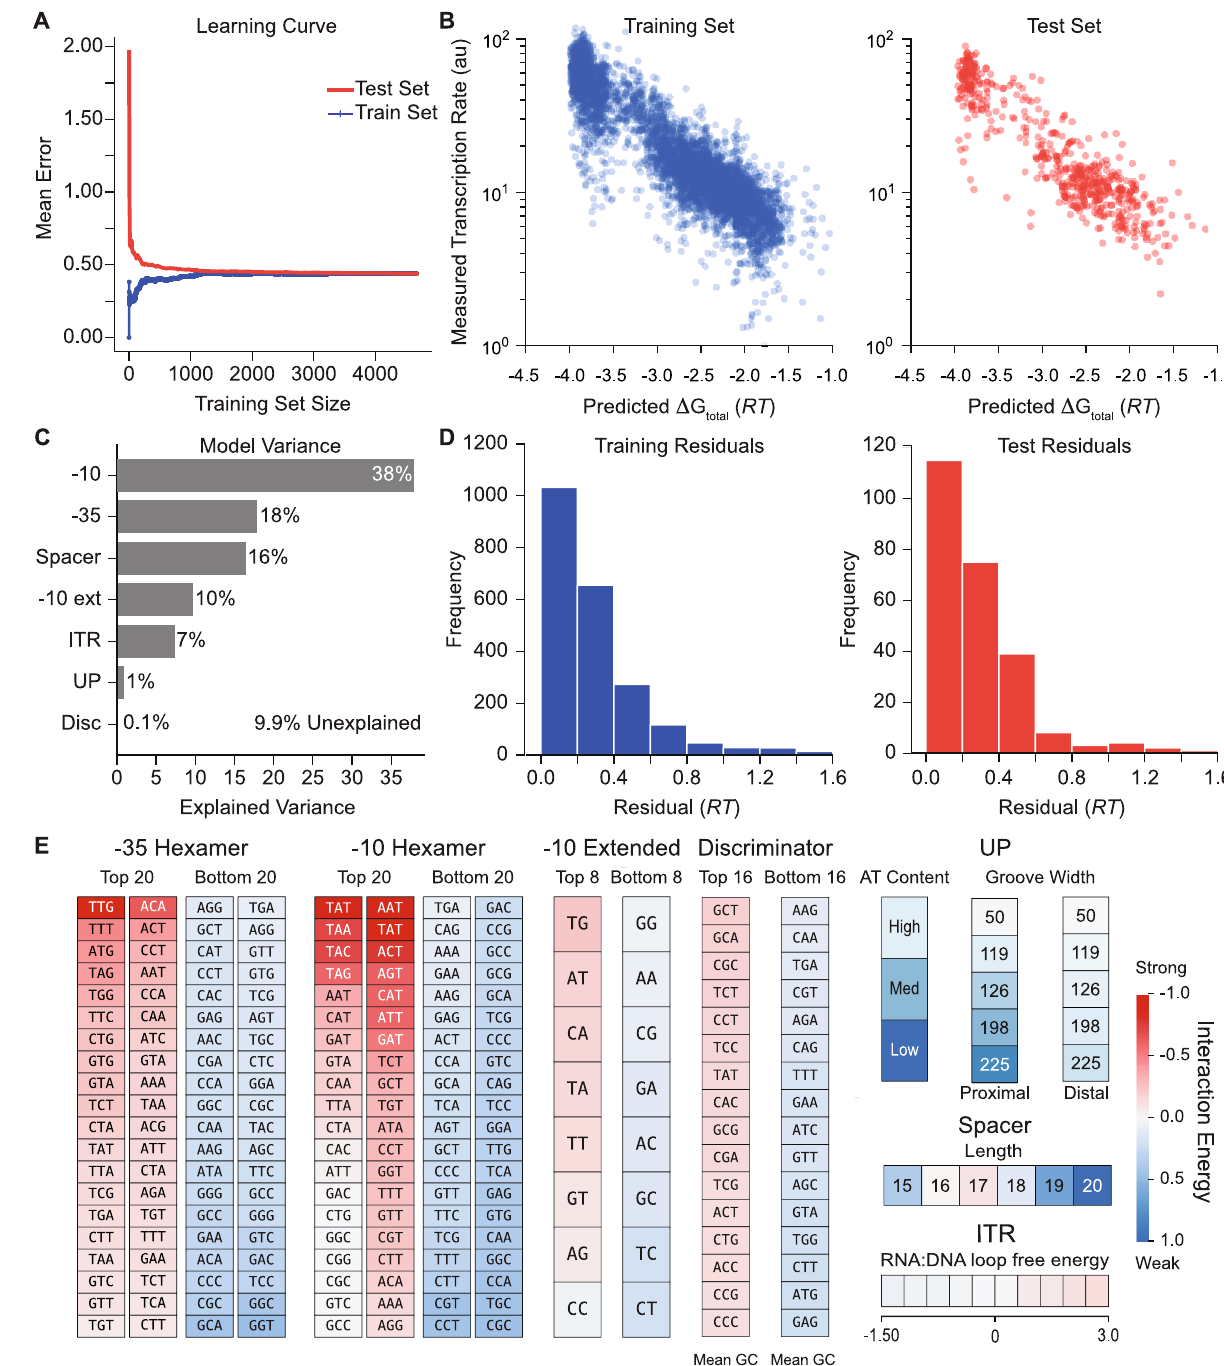
Fig. 2 | Model Development and Validation using Machine Learning. A A learningcurveshowsthetrainingandtestingofaridgeregressionmodeltoidentify the unknown interaction energies. B Model-predicted free energies are compared to measured transcription rates for both (left) the training set and (right) the unseen test set. Pearson correlation coef fi cient ( R 2 ) is equal to 0.80 for both the training and test sets. C The explained variances for each promoterinteraction are